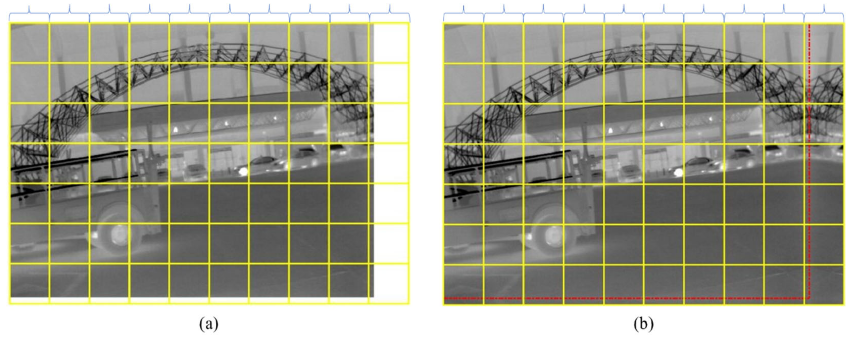
Figure 4. Image block division. ( a ) The raw image; ( b ) The filled image.